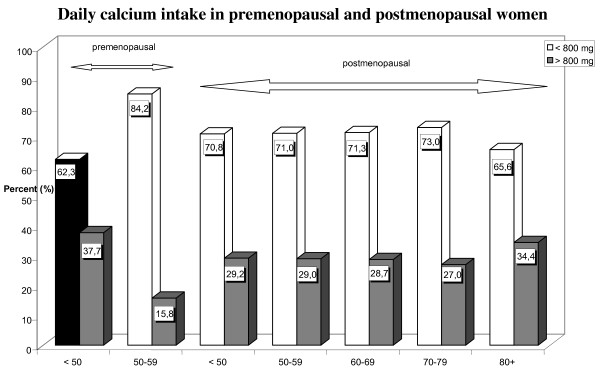
Daily calcium intake in premenopausal and postmenopausal women. This figure depicts the daily amounts of dietary calcium intake (and percent) according to menopausal status using 800 mg daily as cut off point.